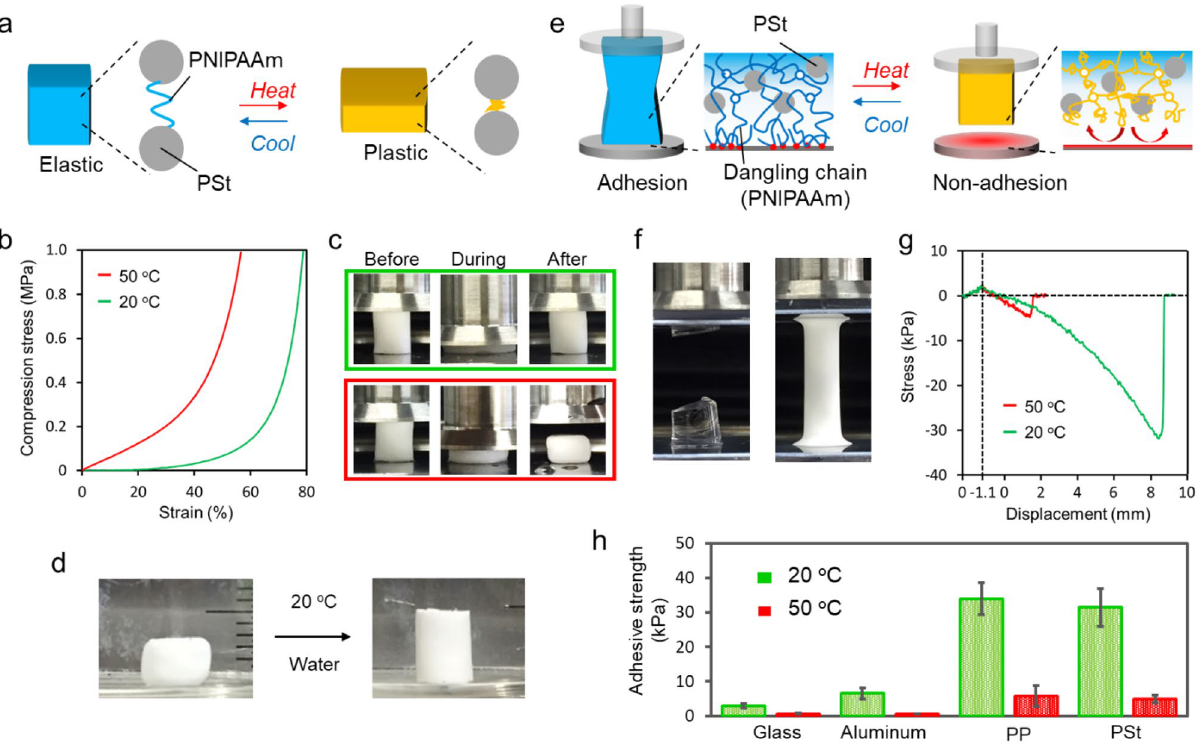
Figure 4. ( a ) Elastic–plastic modulation by temperature. ( b ) Stress–strain curves of composite gels at 20 and 50 °C and ( c ) images of composite gel during compression experiment. ( d ) By immersion into water at 20 °C, plastic deformed composite gels at 50 °C returned to original shape by swelling into water. ( e ) Adhesion control utilizing dangling chains on the surface of composite gels. ( f ) Image of PNIPAAm (left) and composite (right) gels during adhesion strength measurement. The PNIPAAm gel itself broke due to its low mechanical strength. ( g ) Adhesive strength of composite gels at 20 and 50 °C. ( h ) Adhesive strength of composite gels for glass, aluminum, PP, and PSt at 20 and 50 °C. Values is mean ± SD when three measurements are performed using different